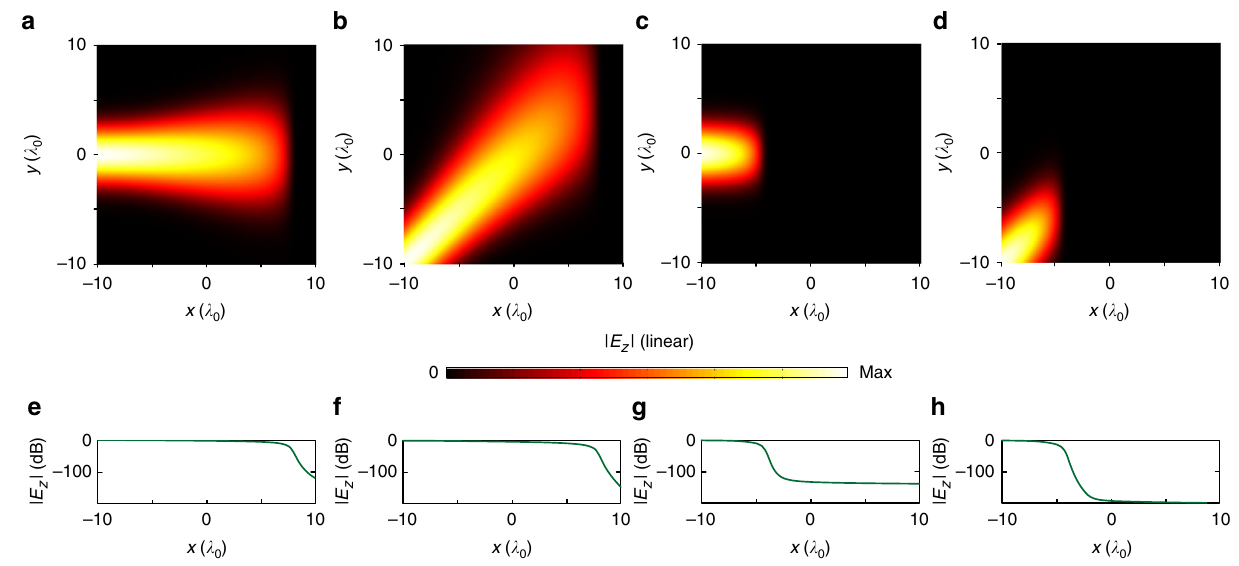
Fig. 2 Simulations with different locations of Gaussian beam sources. In the simulation, parameters ω p , γ , and q in the permittivity pro fi le ε ( ω , x ) described by Eq. (2) are set as ω p = 0.4 ω 0 , γ = 0.03 ω 0 , and q = 0.5 ω 0 , respectively. Simulations at the frequency of 0.6 ω 0 ( a , b ) and 1.2 ω 0 ( c , d ) are performed, respectively. In a and c , the Gaussian beam source is located at ( − 10 λ 0 , 0), and the incident angle of the Gaussian beam with respect to the x axis is 0 º . In b and d , the Gaussian beam source is located at ( − 10 λ 0 , − 10 λ 0 ), and the incident angle is 45 º . e – h The intensity drops along the propagation directions in dB scale are provided, respectively. In all fi gures, the Gaussian beams are continuously dissipated and eventually absorbed in the resonance region without any observable re fl